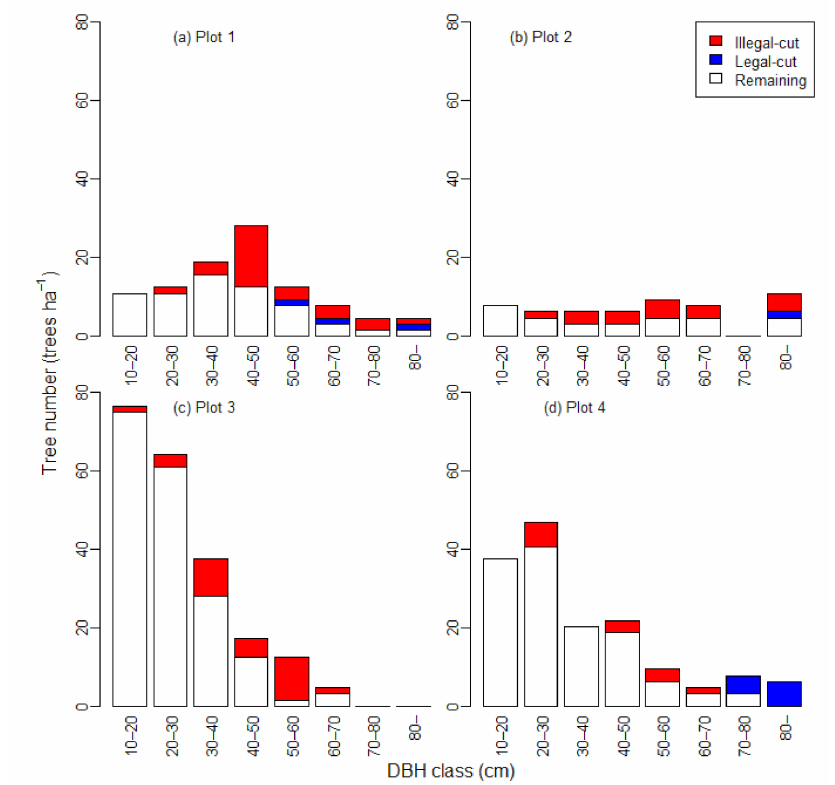
Figure 3. Diameter at breast height (DBH) distribution prior to the latest legal logging in 2011 and the classification after the legal logging up 2013 for plots 1 to 4 ( a – d